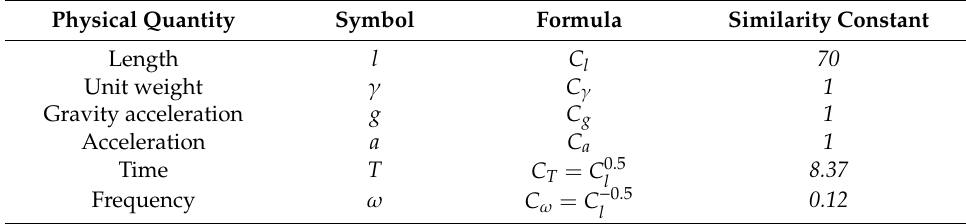
Table 5. Similarity constants of seismic wave